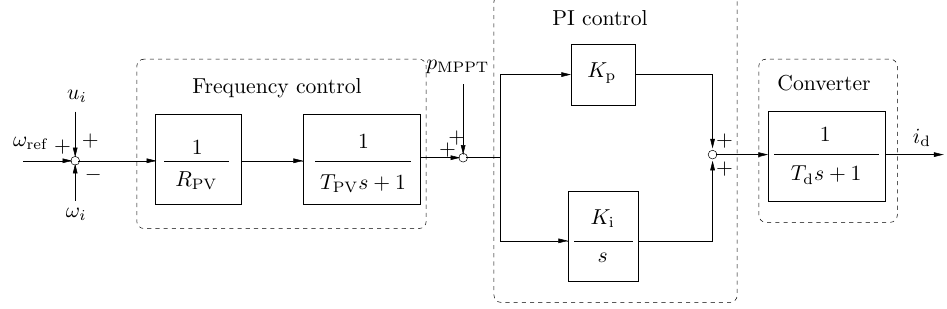
Figure 3. Frequency control of